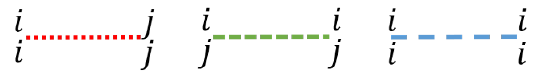
Figure 15. The chains for N